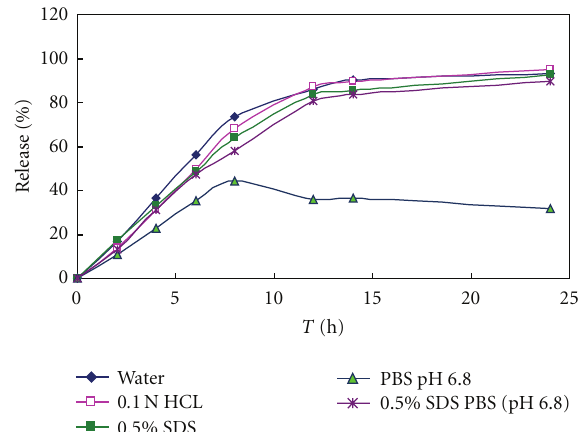
Figure 6: Release profile of optimal osmotic pump tablets formu- lation in di ff erent release media: water, 0.1 N HCL, 0.5% SDS, PBS pH 6.8, 0.5% SDS PBS (pH 6.8).